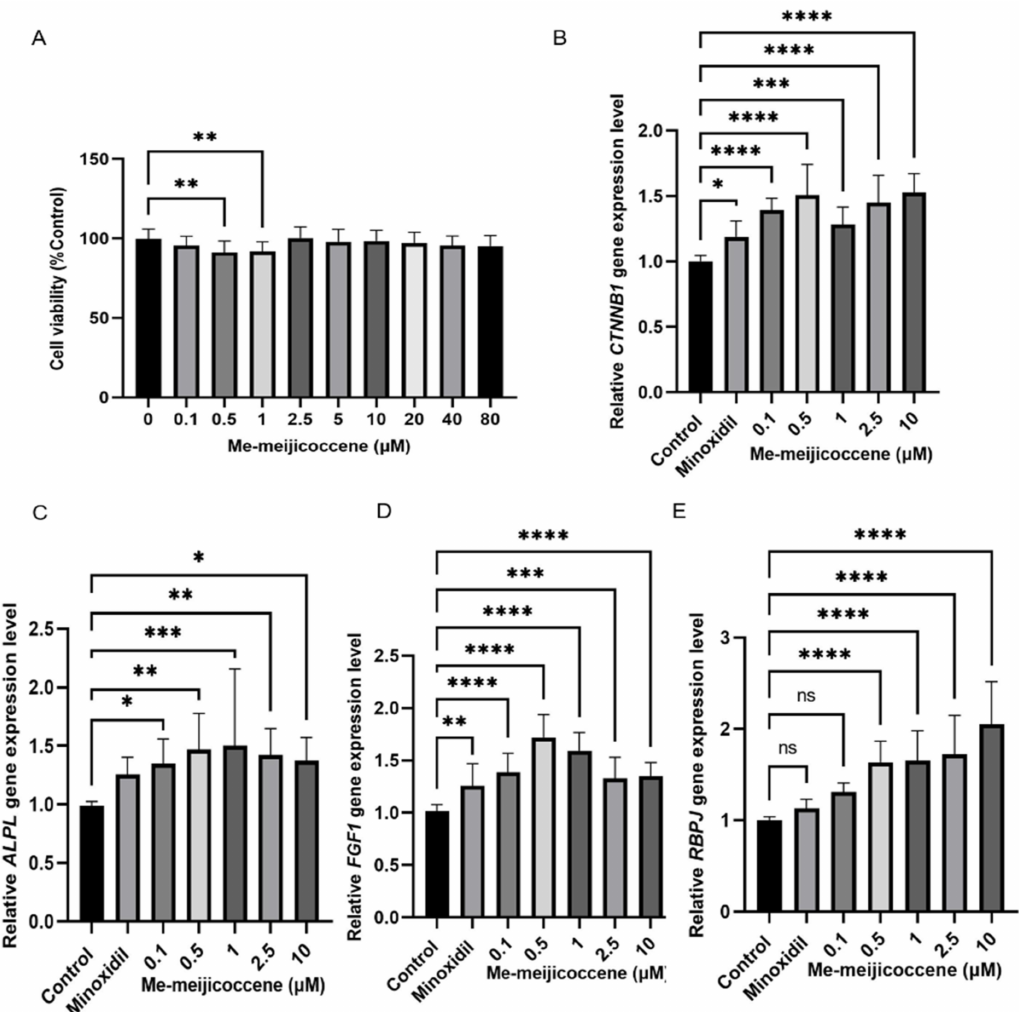
Figure 7. Me-meijicoccene enhanced the gene expression of hair growth-associated markers. ( A ) De- termination of the relative cell viability of HFDPCs after me-meijicoccene treatment for 48 h. Valida- tion of the relative gene expression of ( B ) CTNNB1, ( C ) ALPL , ( D ) FGF1, and ( E ) RBPJ . Results are expressed using the mean ± SD of three replicates. An ANOVA test (Dunnett’s multiple comparisons test) was used to assess the level of significance between the groups. * Statistically significant ( p - value ≤ 0.05), ** statistically significant ( p -value ≤ 0.01), *** statistically significant ( p -value ≤ 0.001), **** statistically significant ( p -value ≤ 0.0001), ns (not